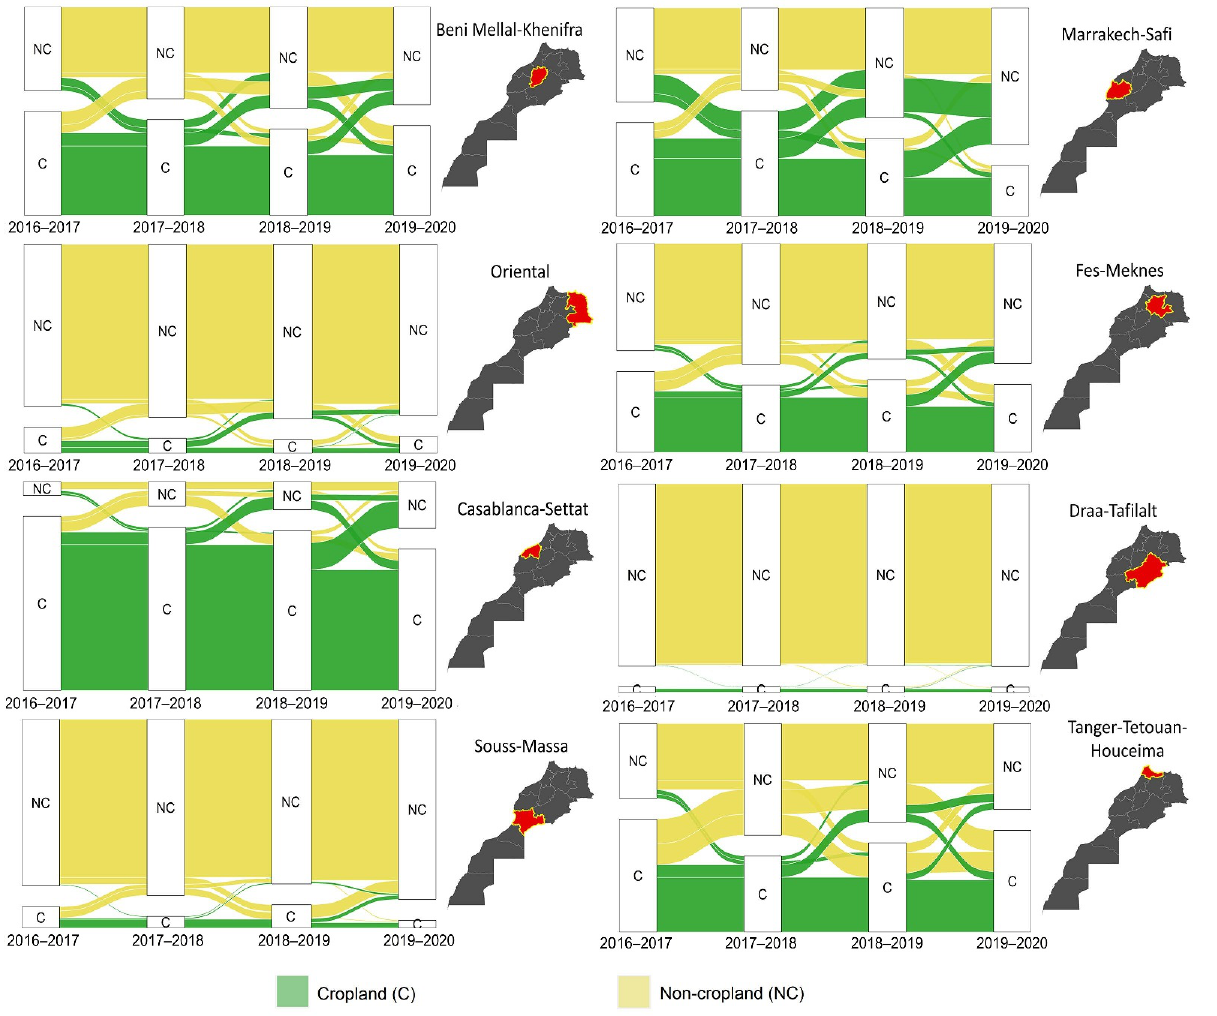
Figure 16. Sankey chart showing frequency distribution of the cropland and non-cropland areas derived in this study per province and season over 2016–2020